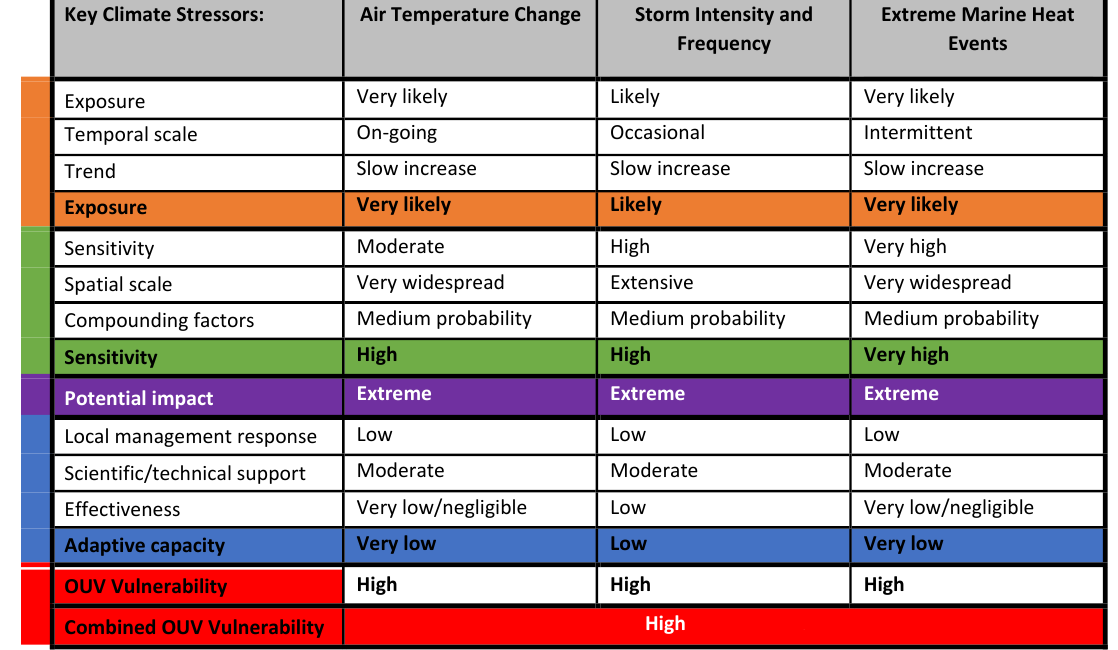
Table 5.2 Rapid assessment of OUV Vulnerability to identified three key climate stressors. Assessed values of exposure, sensitivity and adaptive capacity contribute to derived outcomes for potential impact and OUV Vulnerability. Colours refer to the elements of the CVI framework (Fig.